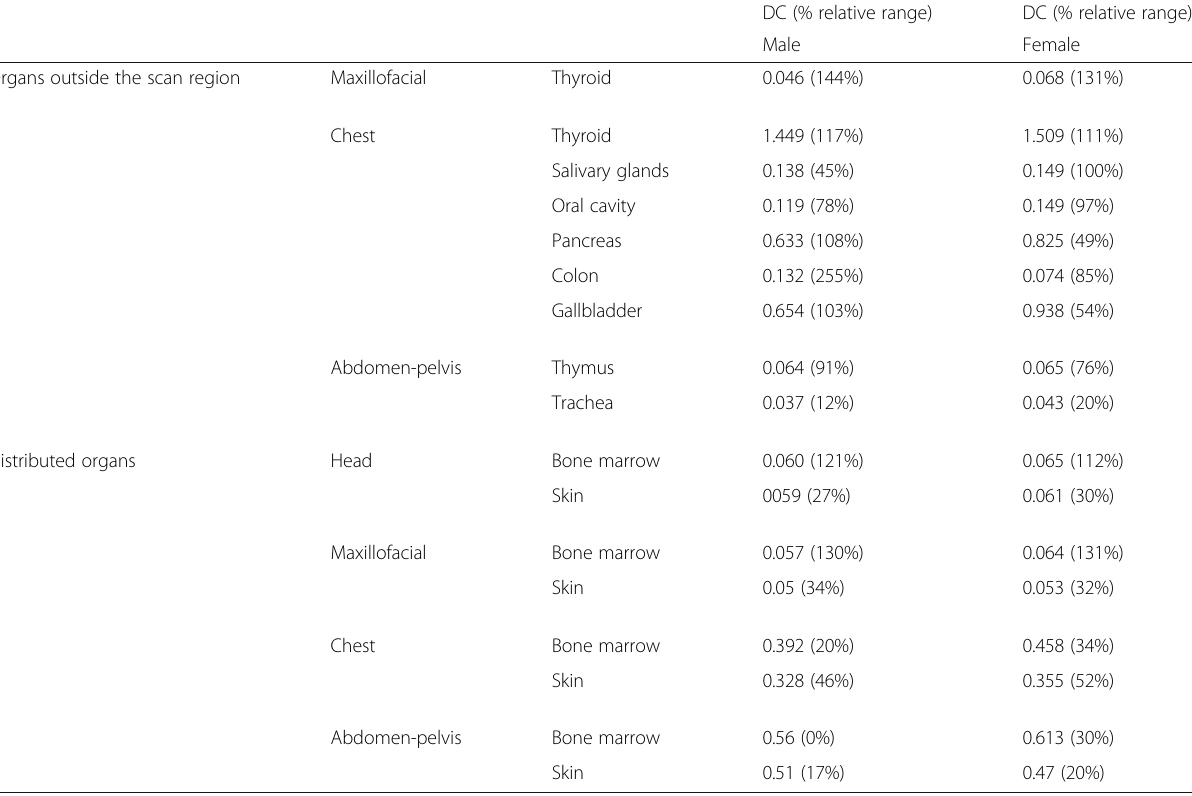
Table 6 Dose coefficients obtained as an average of the values calculated by the software CT-Expo, NCICT, NCICTX, and Virtual Dose. In brackets, the range is shown as the difference between maximum and minimum, divided by the mean value (Continued) DC (% relative